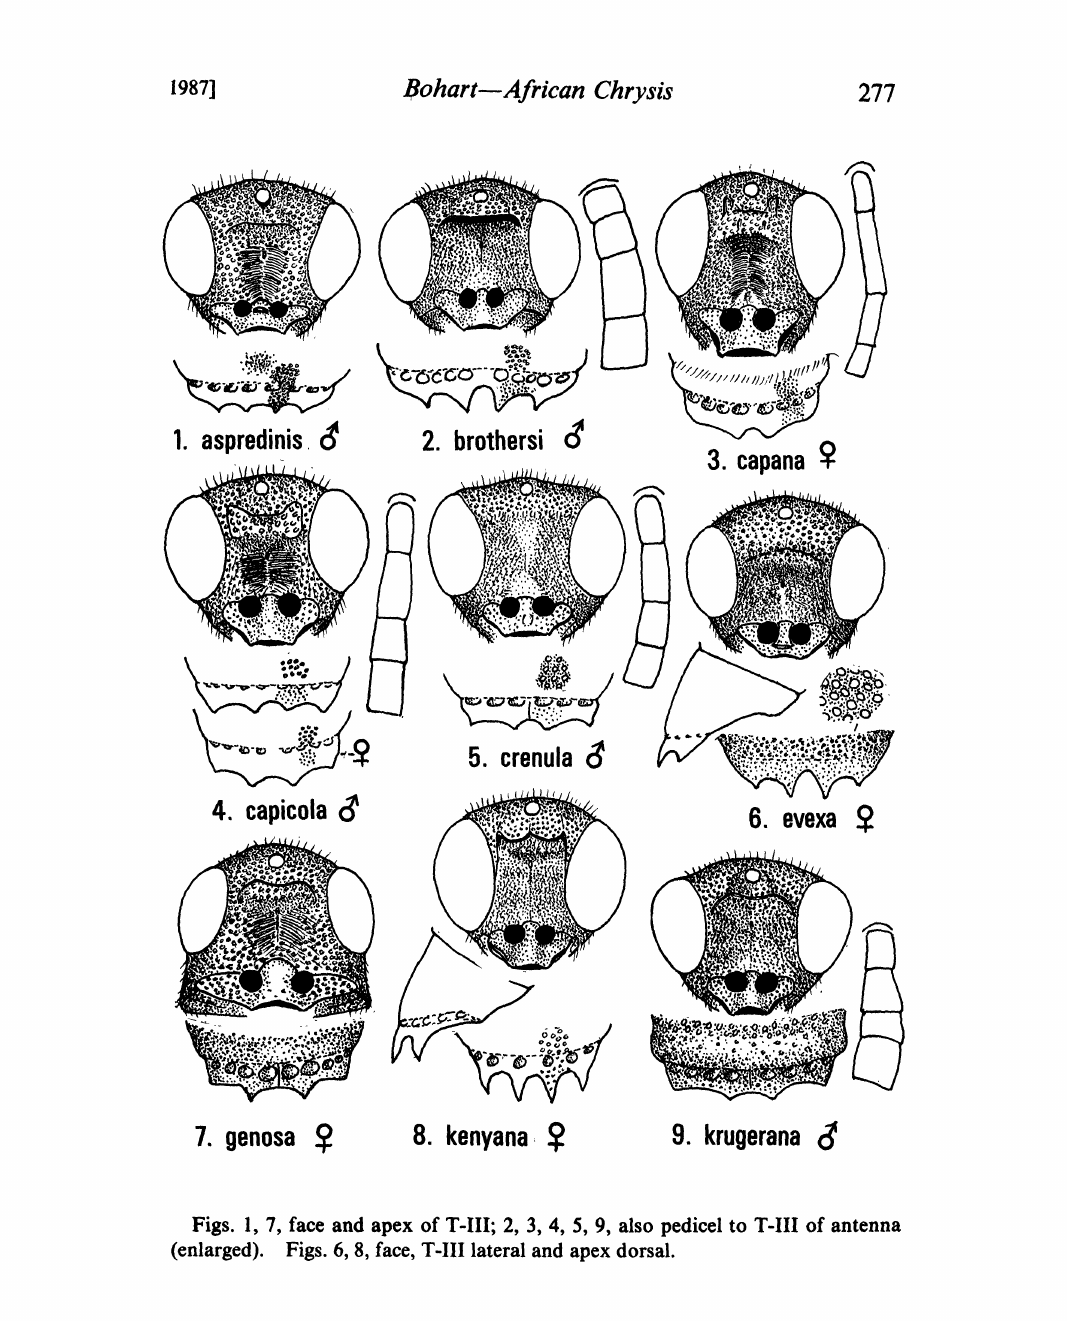
Figs. 1, 7, face and apex of T-III; 2, 3, 4, 5, 9, also pedicel to T-III of antenna (enlarged). Figs. 6, 8, face, T-Ill lateral and apex